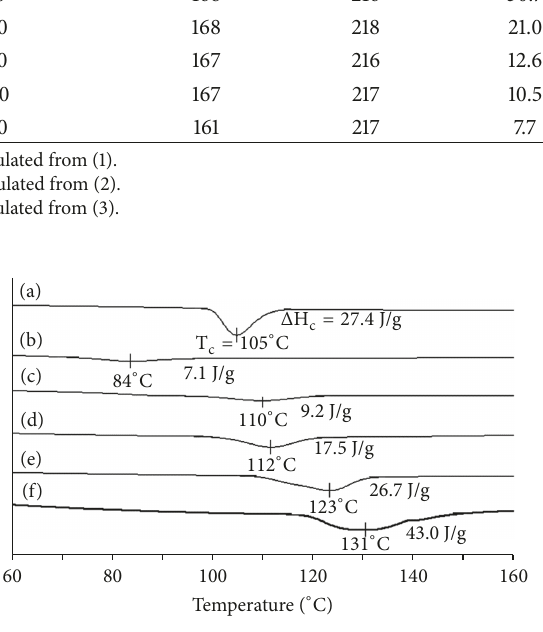
Figure 2: DSC cooling thermograms of blends with PLLA-PEG- PLLA/PDLA-PEG-PDLA ratios of (a) 100/0, (b) 90/10, (c) 80/20, (d) 70/30, (e) 60/40, and (f) 50/50 (w/w) (T shown).